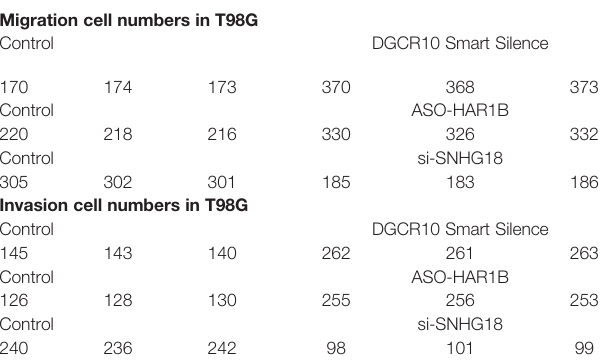
TABLE 4 | Representative counting of migration and invasion assays after knockdown of DGCR10, HAR1B, and SNHG18 in different glioma cell lines. Migration cell numbers in T98G